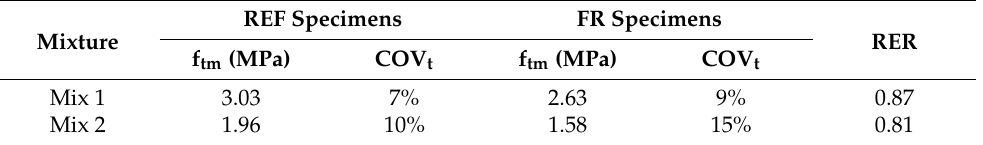
Table 4. Results of flexural strength of NC specimens according to the type of mixture. Mixture